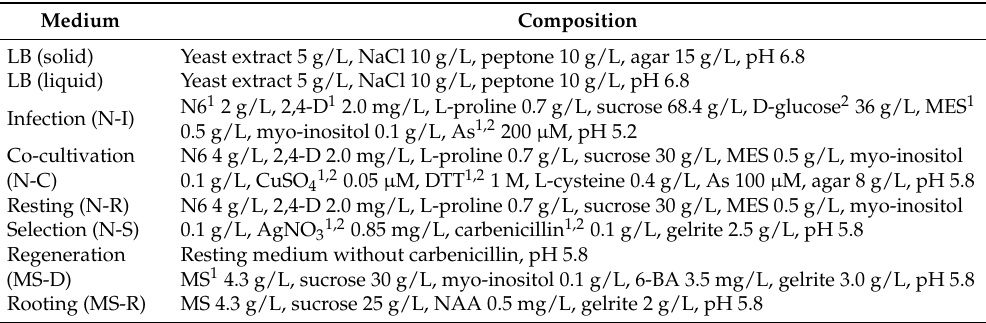
Table 5. Composition of media used in Agrobacterium -mediated